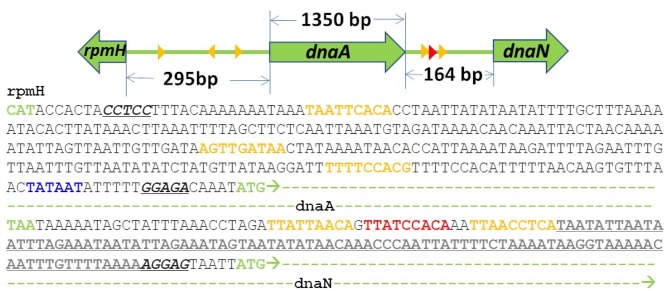
DNA sequence near oriC of JCVI-syn3A defined by the 3 high (red) and low (yellow) affinity DnaA(IV) binding sites: The AT-rich region (bold and underlined) binds DnaA(III). The AT-rich region ends at the Shine-Dalgarno sequence (italicized and underlined) preceding the dnaN gene (green dashes). A putative promoter for the DnaA gene preceding its Shine Dalgarno sequence is shown in blue.